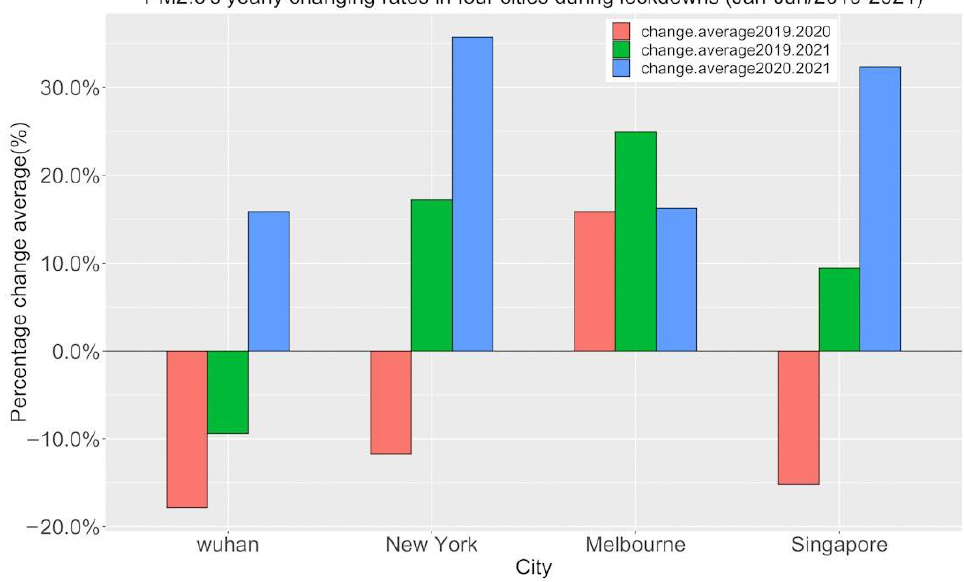
Figure 10. Yearly PM2.5 changing rates in four cities during lockdowns (Jan – Jun/2019 – 2021).